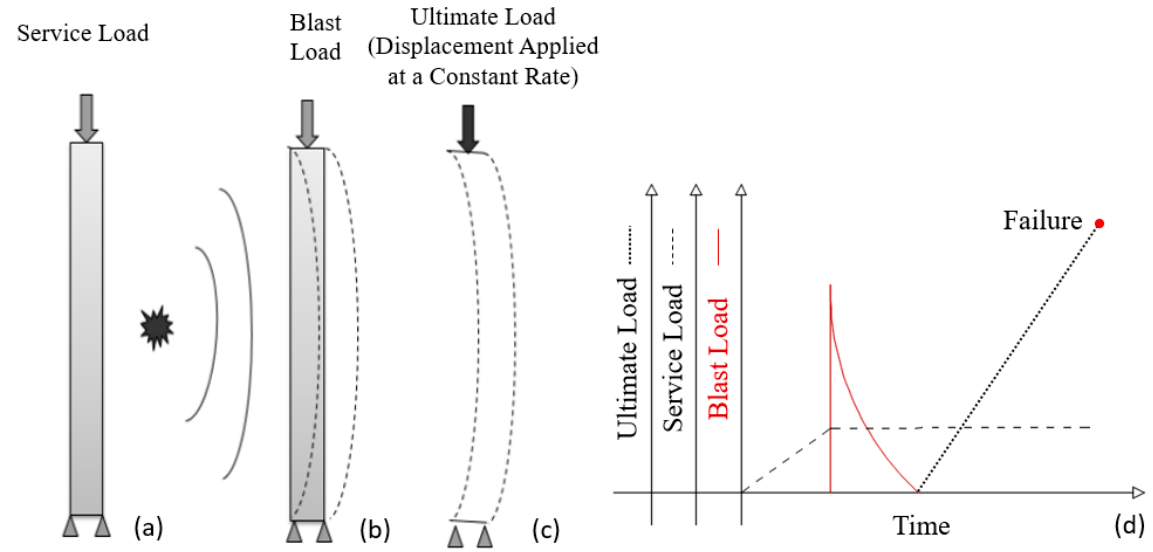
Figure 25. Application of ( a ) service load, ( b ) blast load, ( c ) ultimate load, and ( d ) illustration of the load protocols applied in the FE analysis.